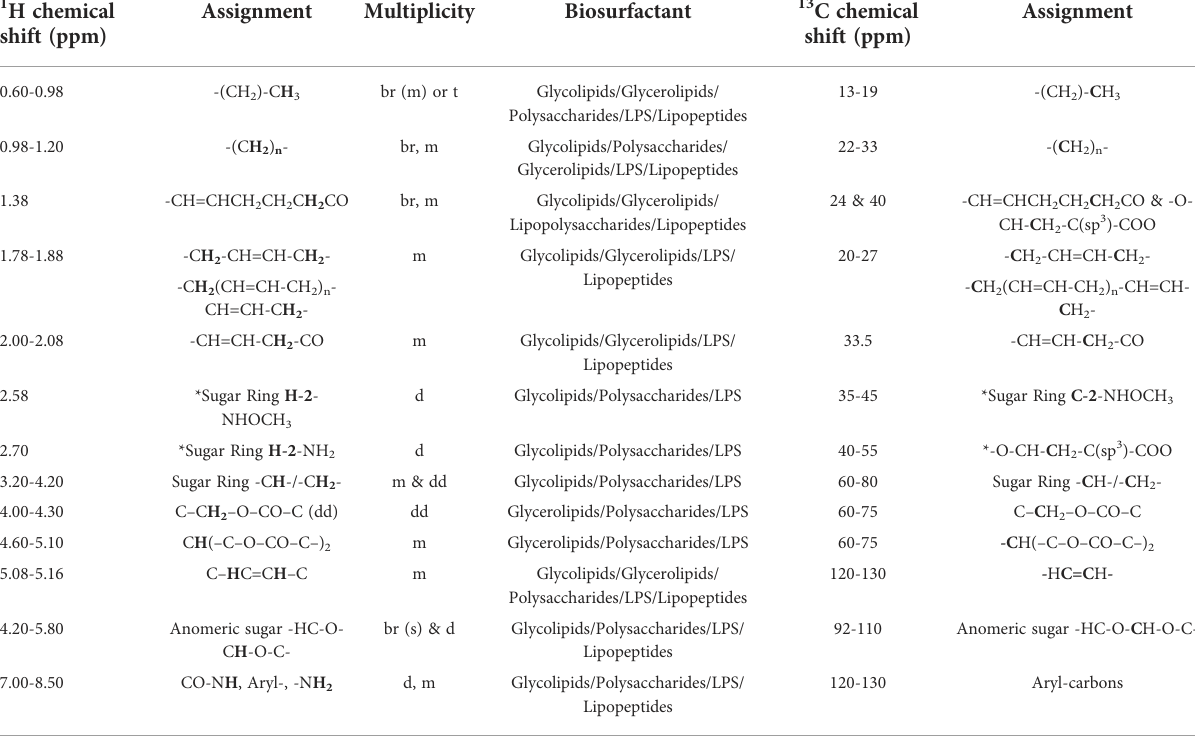
TABLE 2 Common chemical shifts of characteristic and functional groups of Biosurfactants ’